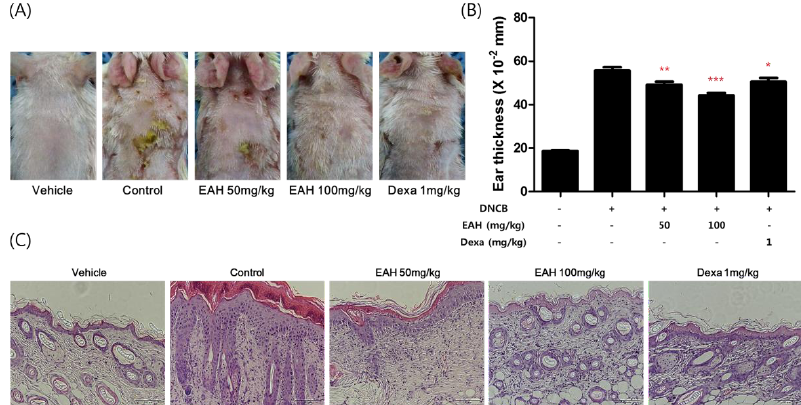
Figure 5. Effects of EAH on development of DNCB-induced AD mouse skin lesions. ( A ) Effects of